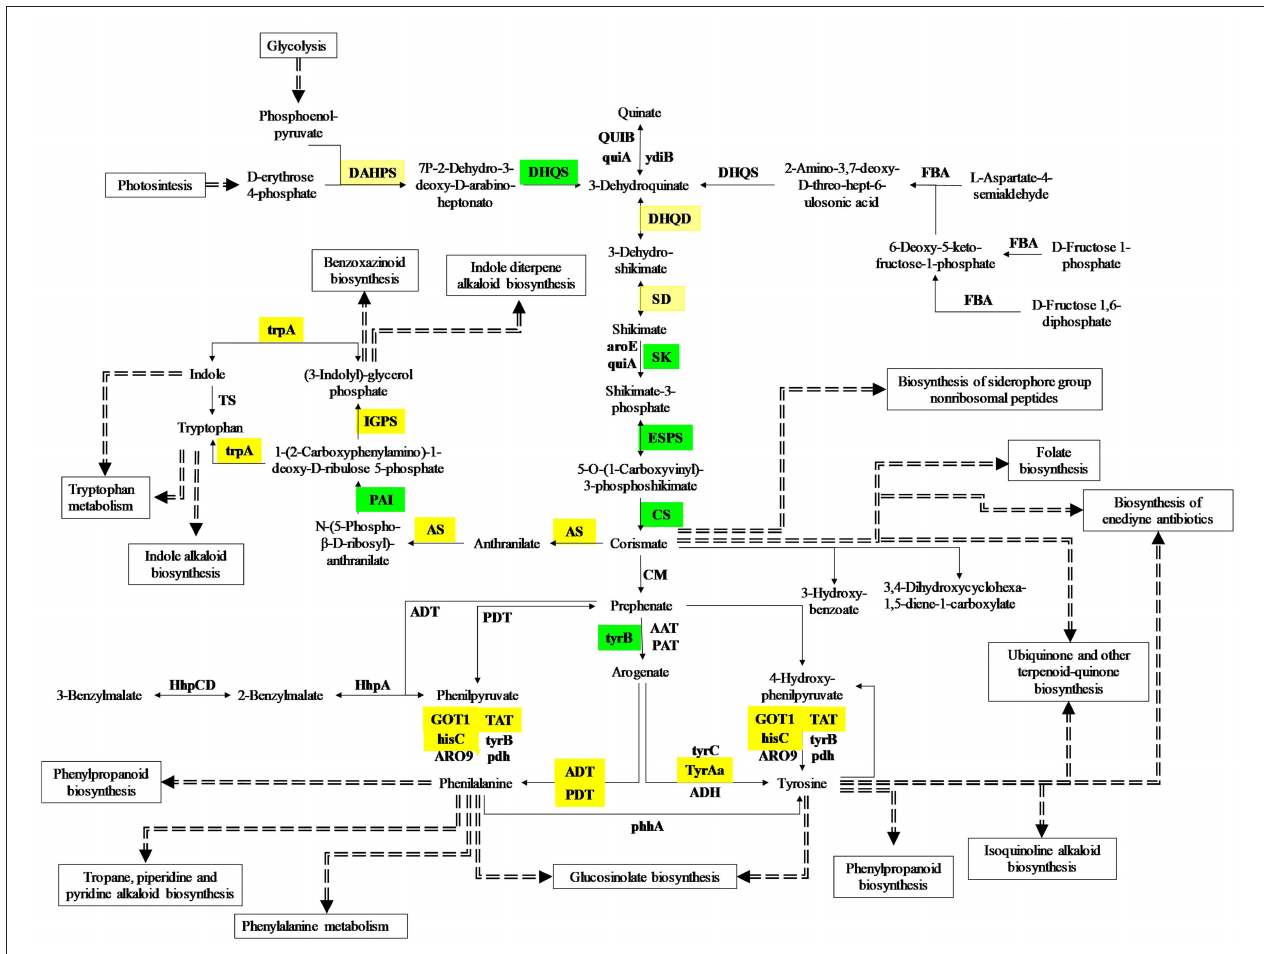
FIGURE 3 | DEG genes are involved in the aromatic amino acid pathway. Red squares indicate upregulated genes. Green squares indicate downregulated genes. Yellow squares show both up- and downregulated